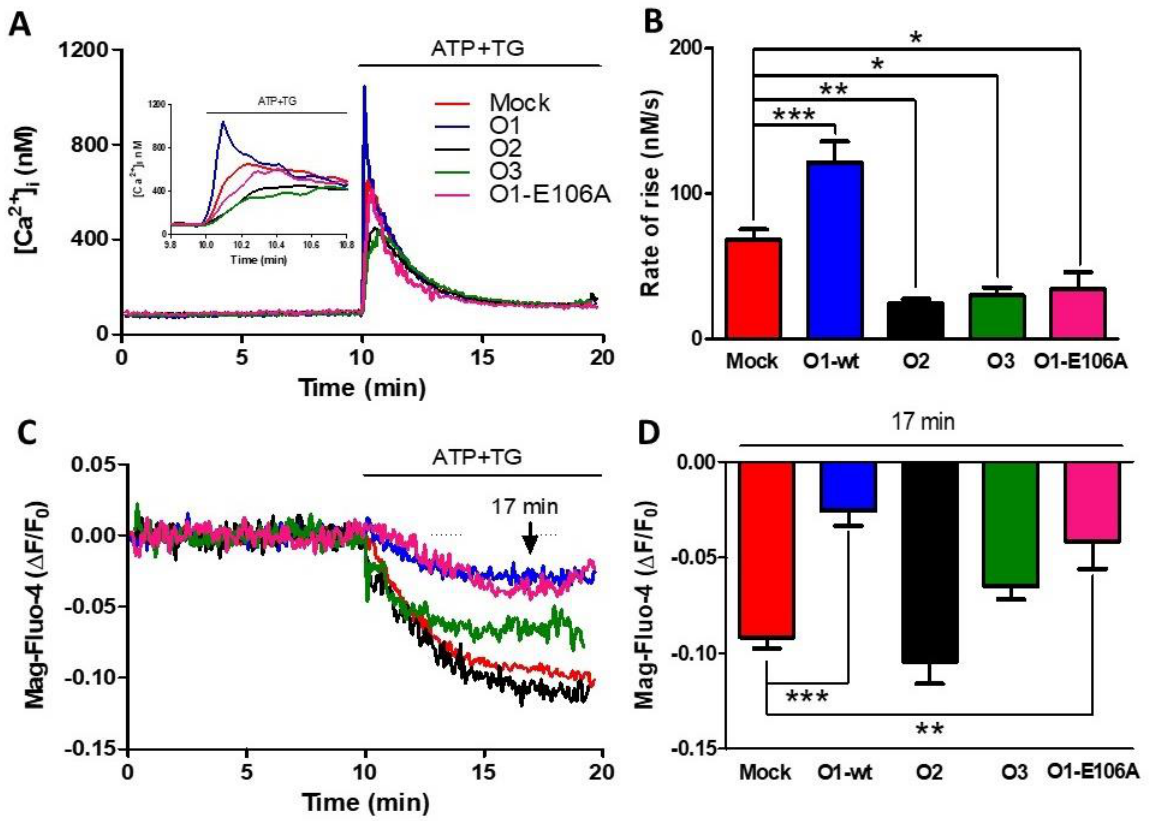
Figure 1. The dominant-negative mutant of the Orai1 channel (O1-E106A) inhibits the rate of agonist-induced Ca 2+ release. ( A ) Time course of changes in [Ca 2+ ] i (assessed with Fura-2) in response to the 10 µM ATP and 1 μM TG application, where indicated, in a 1.8 mM Ca 2+ medium for either mock cells (red trace) or cells overexpressing Orai1 (O1-wt, blue trace), Orai2 (O2, black trace), and Orai3 (O3, green trace) channels, in addition to cells overexpressing the dominant-negative mutant Orai1 E106A (O1-E106A, pink trace). The inset shows the initial ATP and TG induced [Ca 2+ ] i response time